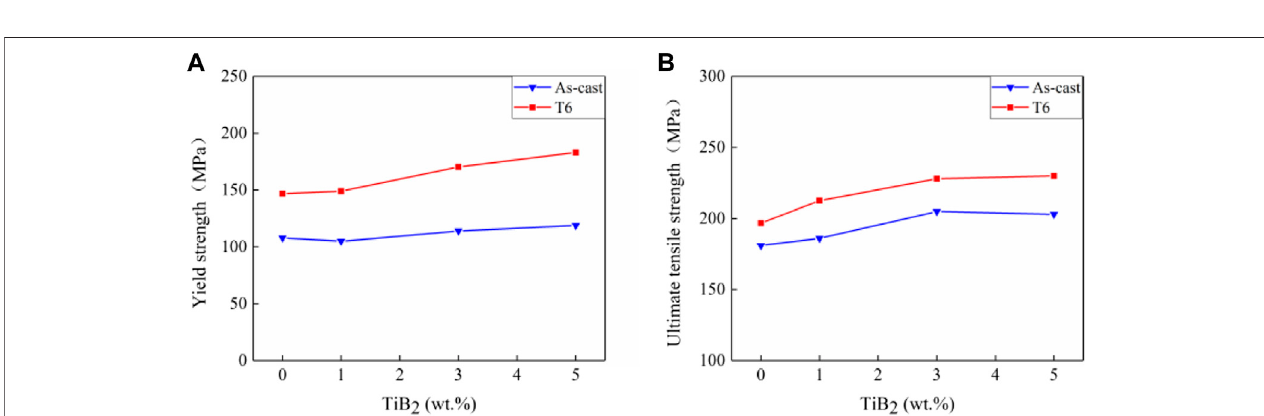
FIGURE 8 | Effect of TiB 2 content on: (A) Yield strength, and (B) Ultimate tensile strength of TiB 2 /A356 composites.